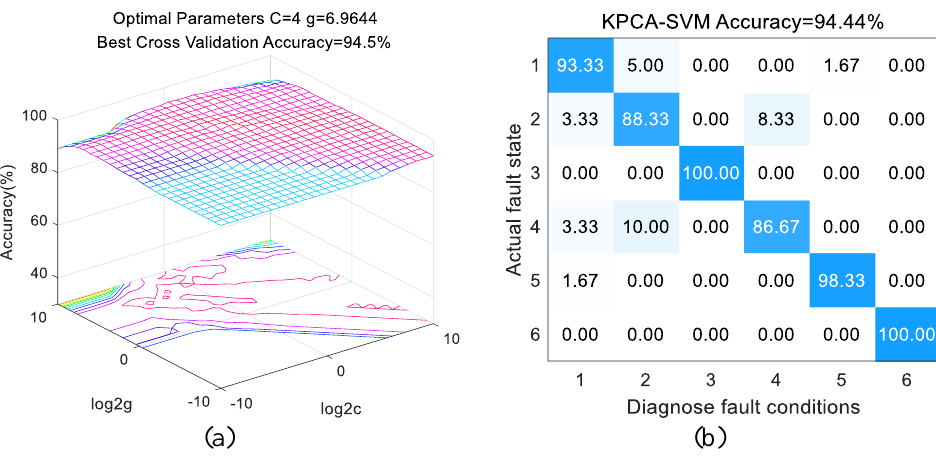
Figure 9. The PCA dimension reduction method: ( a ) optimal parameters; ( b ) classification results.